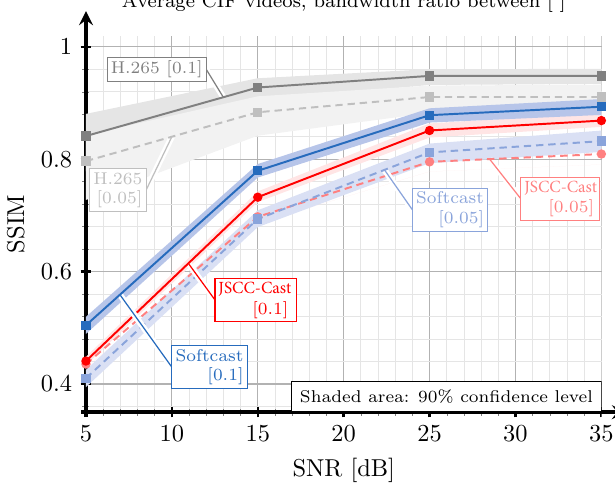
Figure 10. SSIM versus SNR for a selection of videos with CIF resolution extracted from [39]. The red lines correspond to the proposed JSCC-Cast, the blue lines to Softcast, and the grey lines to H.265. The solid lines correspond to a bandwidth ratio of 0.1, and the dashed lines correspond to a bandwidth ratio of